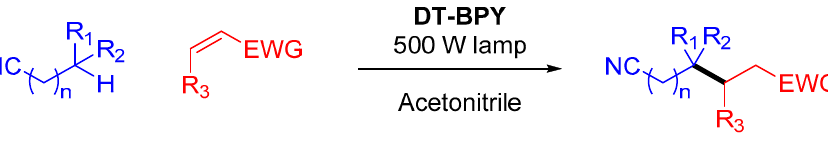
Table 16. Other photocatalytic organic transformations mediated by MOFs.